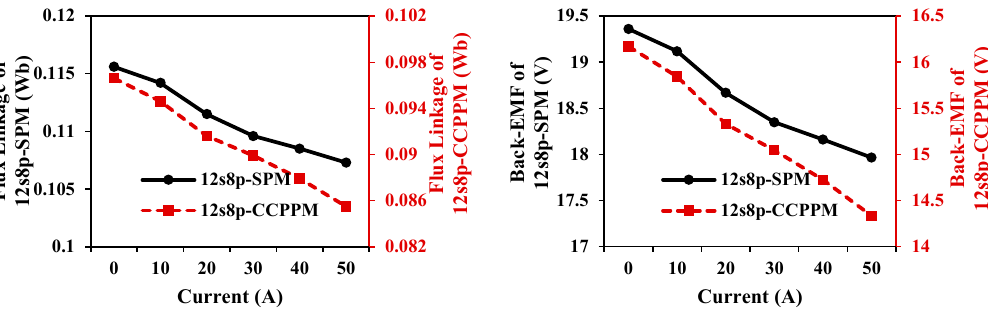
Figure 10. Amplitudes of fundamental harmonics in phase-A for 12s8p machines.